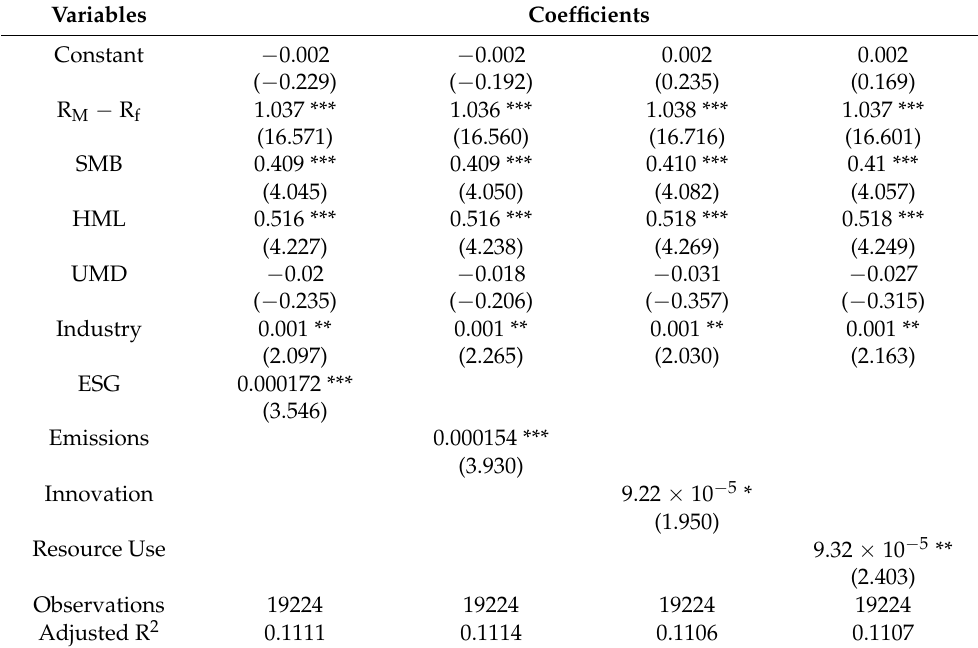
Table 3. Regression